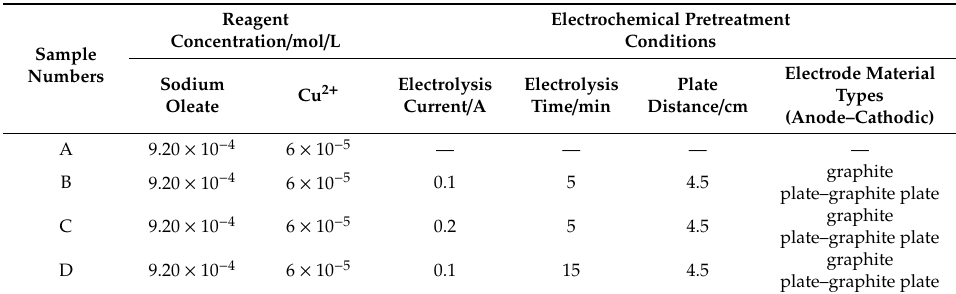
Table 3. Action conditions of di ff erent muscovite